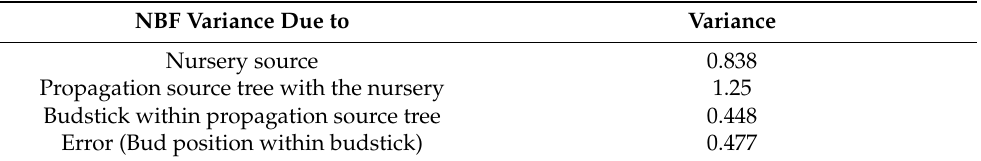
Table 1. Maximum likelihood estimates for the variance components of final noninfectious bud- failure (NBF) in ‘Carmel’ almond expression in the overall